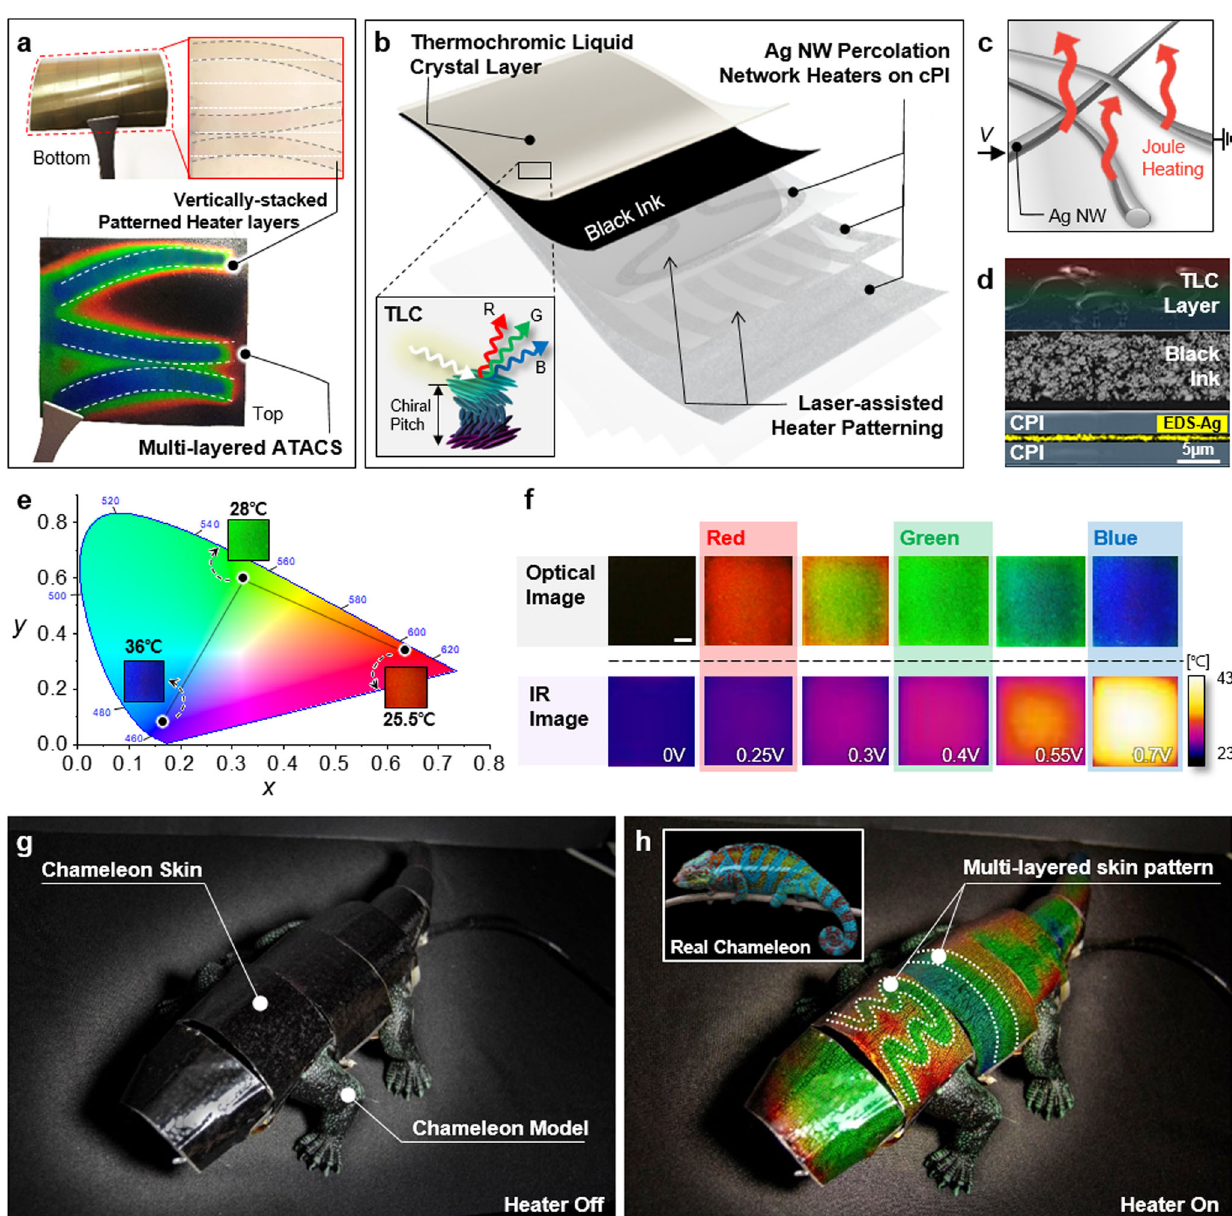
Fig. 1 Multi-layered ATACS capable of generating multiple skin patterns with RGB coloration. a Digital image of Multi-layered ATACS and its bottom image with vertically stacked patterned heater layers. b Con fi guration of the multi-layered ATACS: TLC is coated on the black ink layer. Ag NWs percolation network heaters were stacked on cPI fi lms and patterned by the UV laser ablation process. c The Ag NW heater generates heat with a joule heating mechanism. d SEM image of the cross-section of its EDS image for silver. The scale bar is 5 µ m. e CIE 1931 chromaticity diagram of the ATACS and actual image of it at 25.5, 28, and 36 °C. f Coloring performance of the ATACS depending on various DC voltage. The scale bar is 1 mm. g The chameleon model with 7 of the multi-layered highly fl exible ATACS patches. h Demonstration of the multi-layered ATACT patches on the chameleon model. Inset is a real chameleon with full